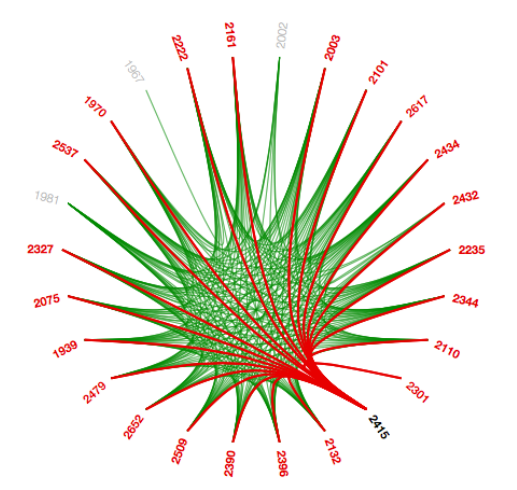
Figure A13. Demonstration of a graph when selection interaction is selected.